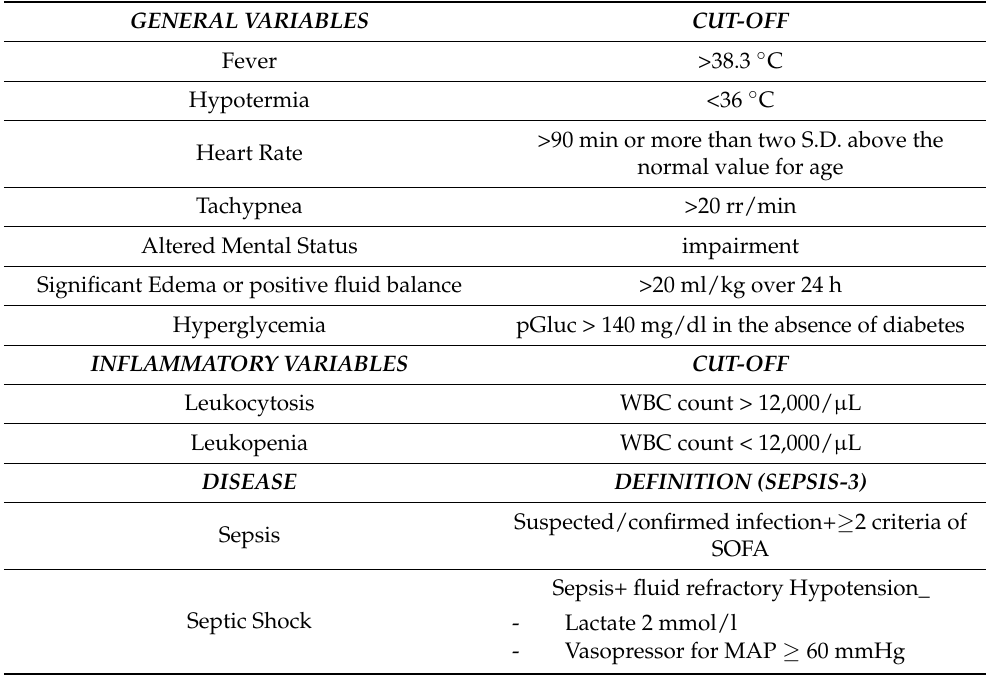
Table 1. Suspected Infection Variables and definition of sepsis and septic